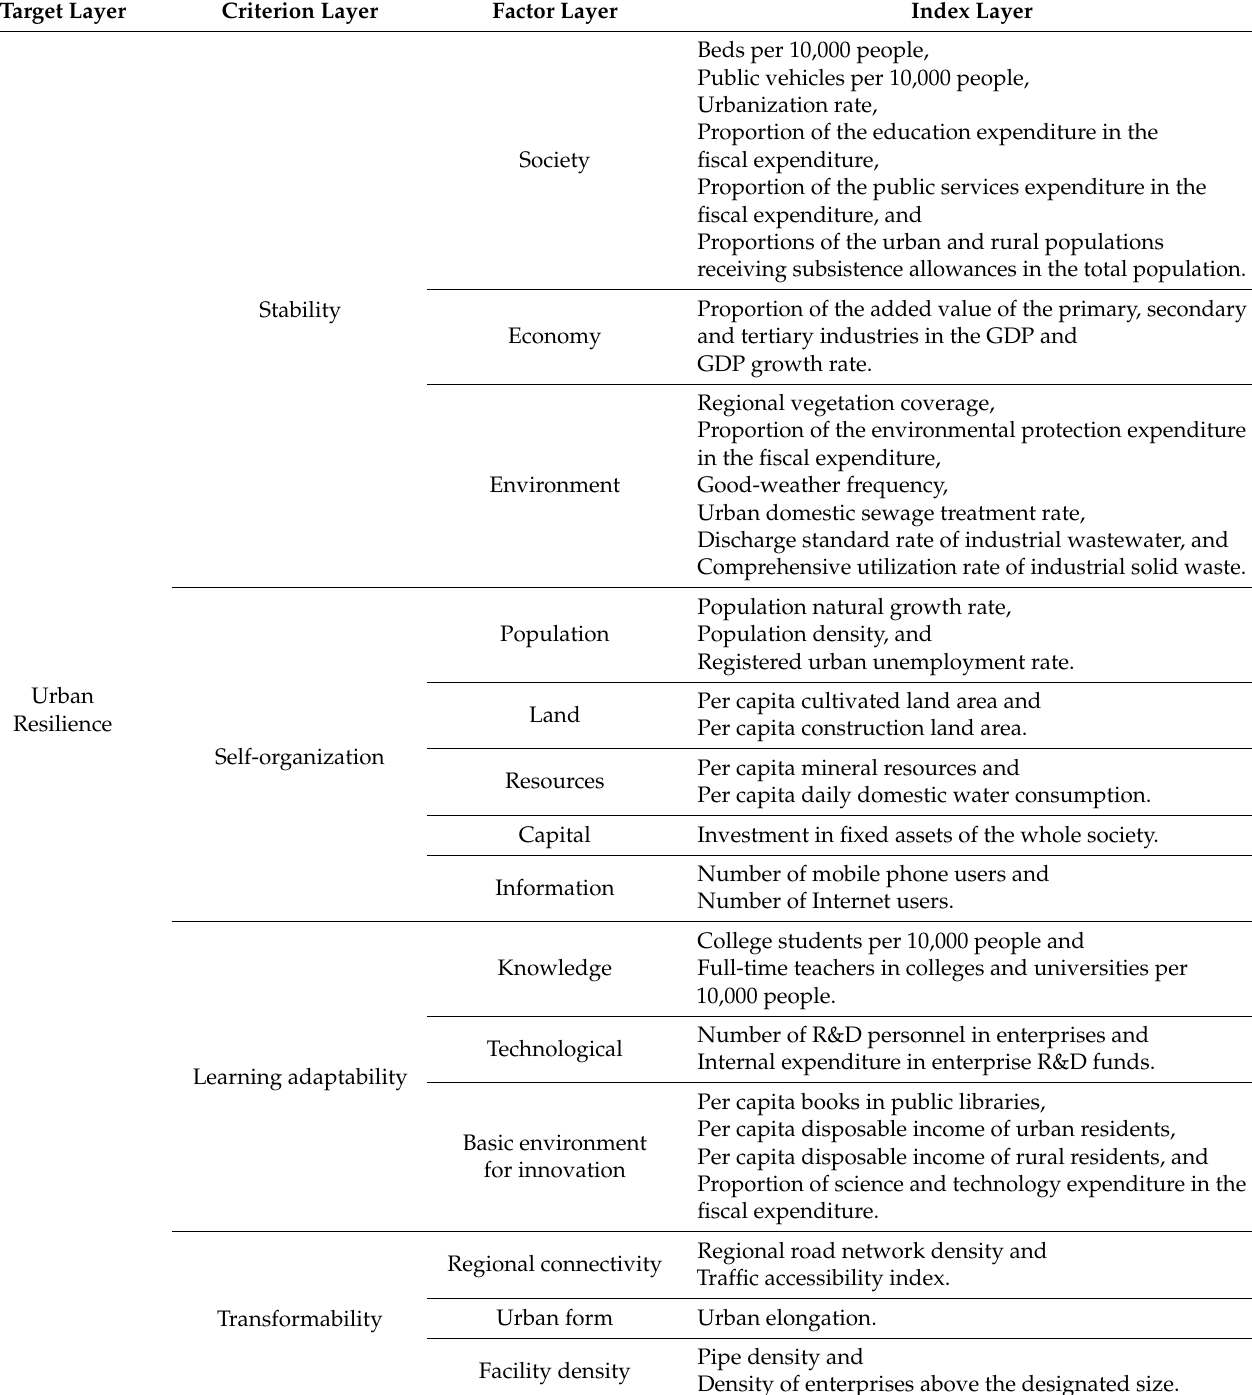
Table 1. The index evaluation system of the urban